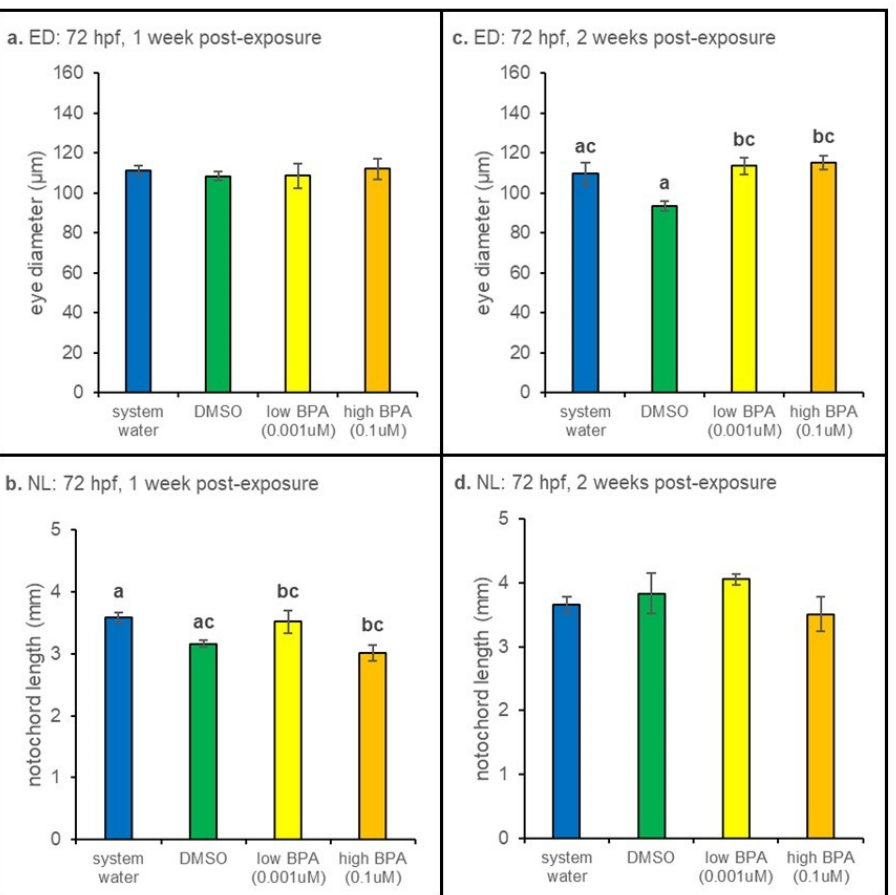
Figure 3. Seventy-two hours postfertilization anatomical measurements. ( a ) Larvae exposed at 72 hpf displayed no significant differences in eye diameter after 1 week of recovery. ( b ) Though significant differences in length were observed ( p = 0.014), BPA- and vehicle-treated animals were not different. ( c ) Eye diameter was significantly increased in both low and high BPA exposure groups at the 2 week time point ( p = 0.006). ( d ) No significant differences in notochord length were evident after 2 weeks of recovery. At each recovery point n = 5 for all treatment groups. Differences in notochord length and eye diameter across treatment were assessed using a one-way ANOVA followed by a Tukey post hoc test at each exposure age. Eye diameter measurements were normalized to notochord lengths prior to statistical analysis. All values are reported as mean ± SE. Different letters denote significance.